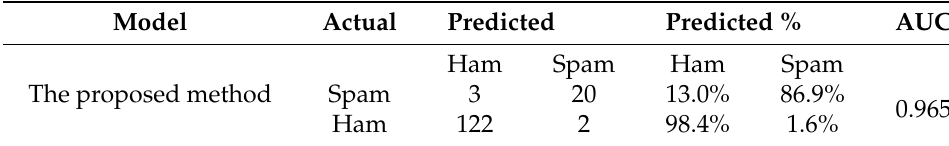
Table 4. Confusion matrix of the experiment’s results.